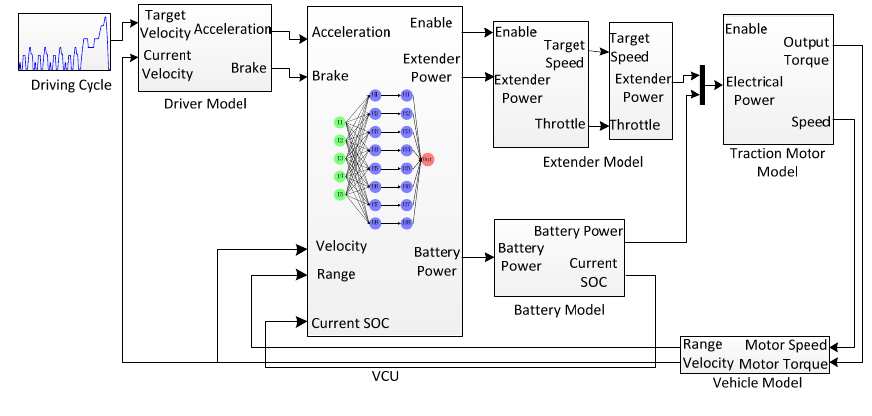
Figure 7. NN controller design diagram.